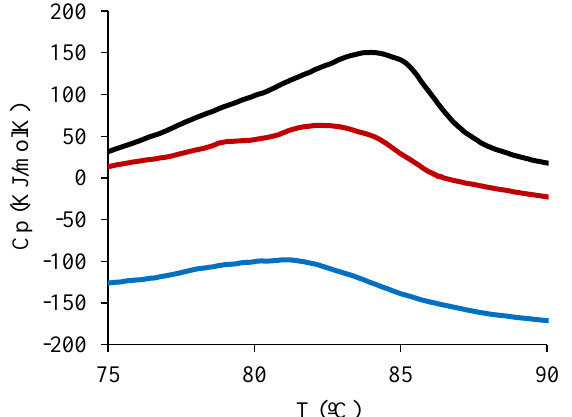
Figure 1. Bovine serum albumin (BSA) release profile from chitosan microcapsules ( ○ ) and chitosan − TPP-microcapsules ( • ). Release medium: Phosphate-buffered saline (PBS) at pH 7.4 and 37 ± 1 ◦ C.